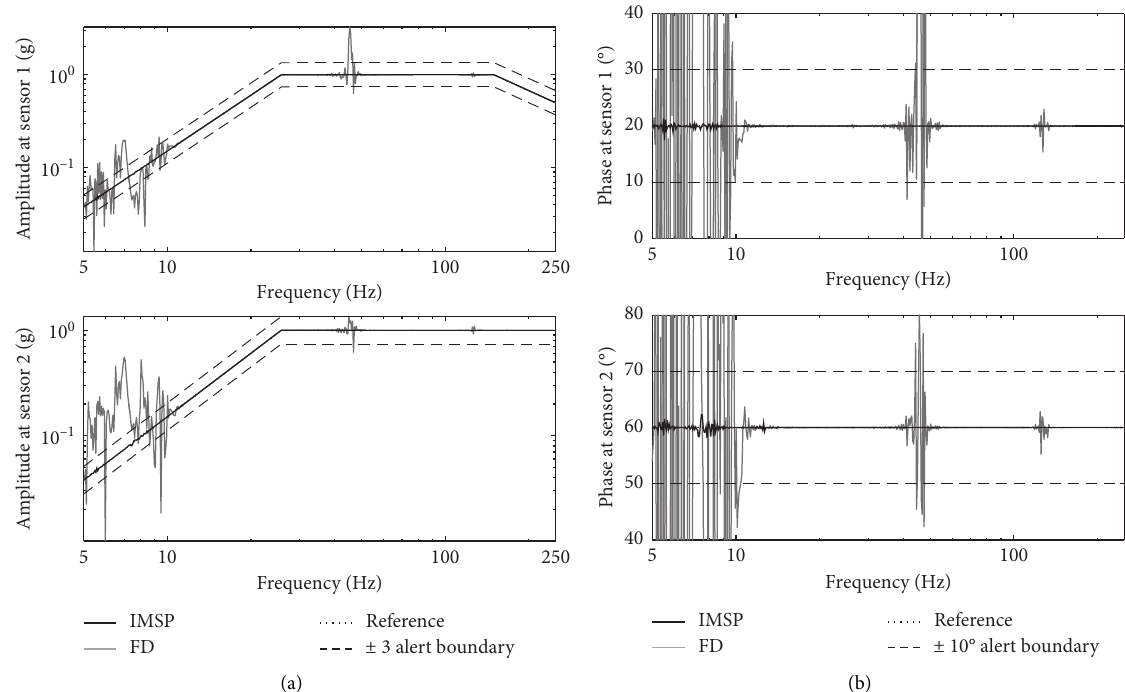
Figure 8: Comparison between the inverse multistep prediction method (IMSP) and frequency-domain method